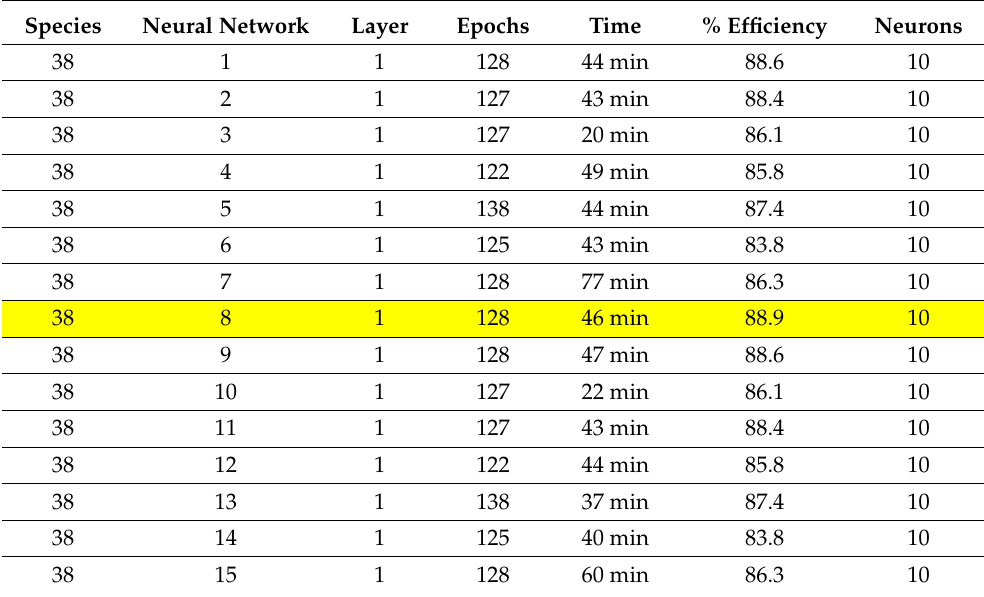
Table 2. First experiment. Fifteen runs of the neural network with 37 species, 1 control group (38 “species”), and 10 neurons in the hidden layer.